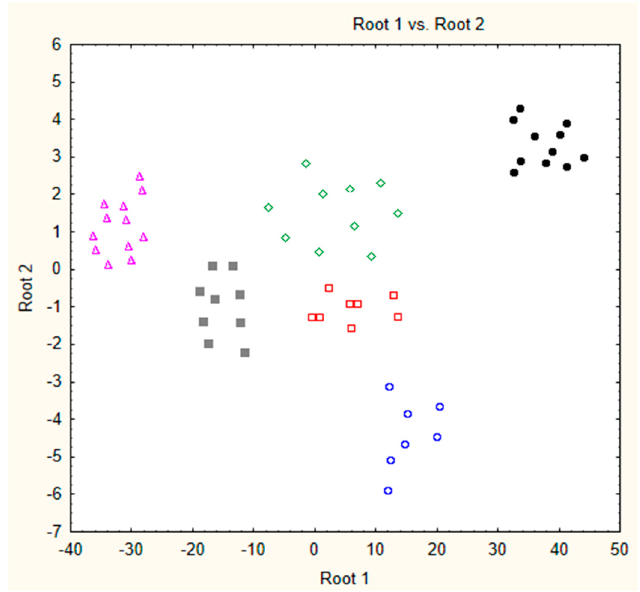
Figure 4. Discriminant analysis with the canonical representation of data: point of sampling. Sampling point.